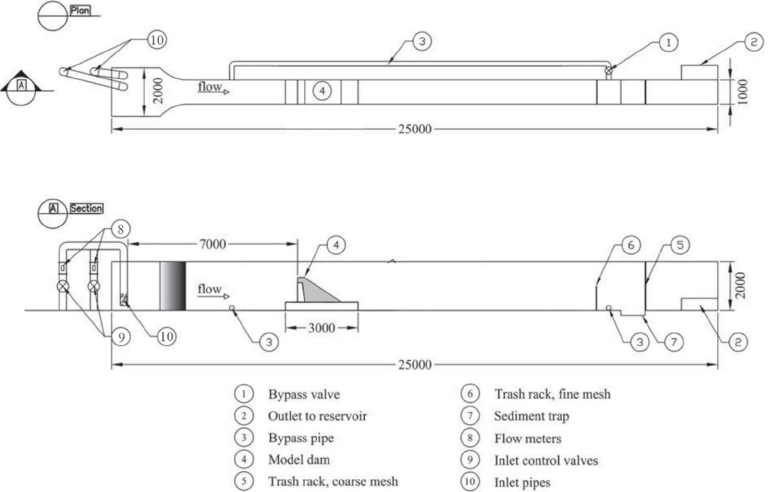
Figure 3. Representation of the flume present at the hydraulic laboratory of NTNU (Trondheim) used for the 9 setups introduced in this work. Modified from Kiplesund et al. [22].